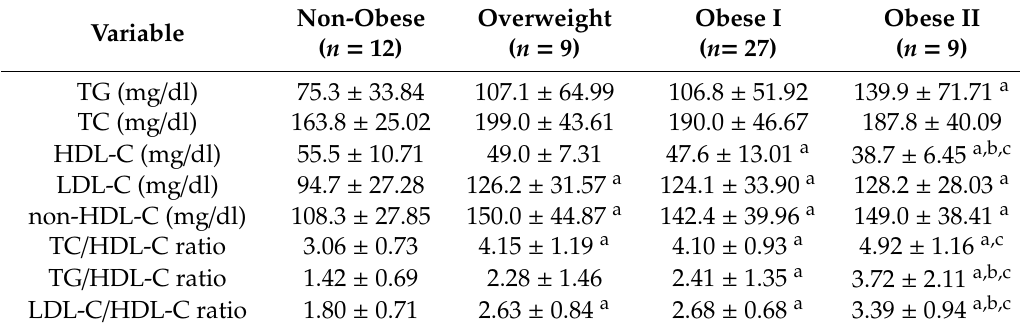
Table 8. The evolution in lipid profile concerning obese